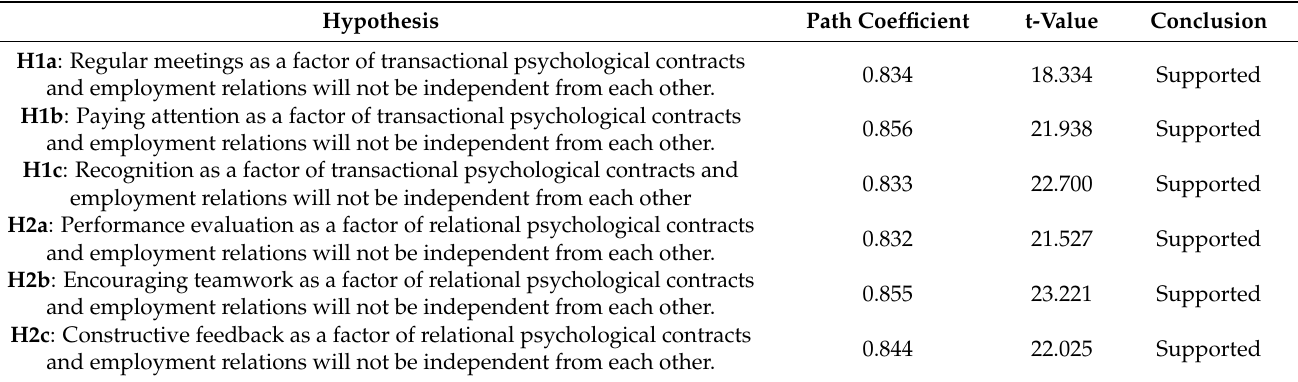
Table 6. Results on